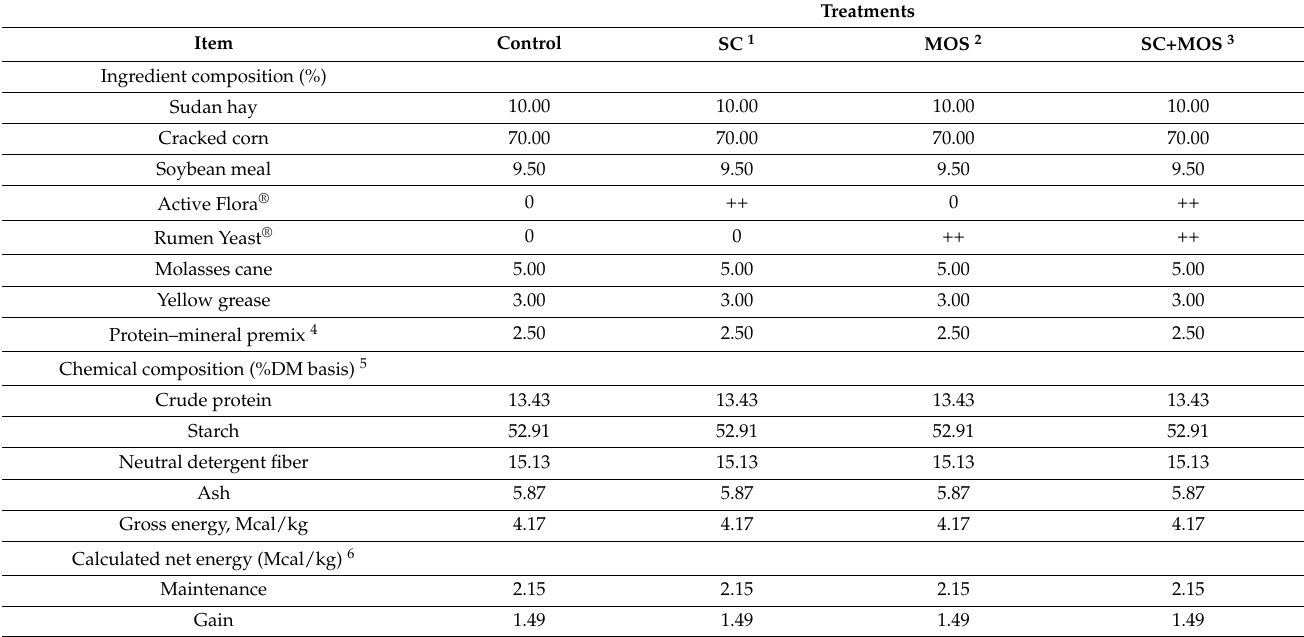
Table 1. Composition of experimental diets offered ad libitum to the